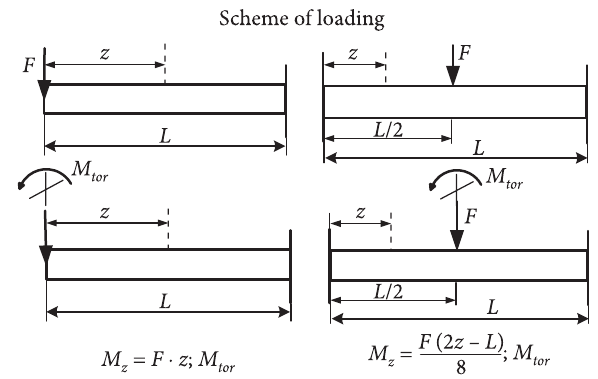
fig. 1. Loading thin-walled constructional elements under complicated